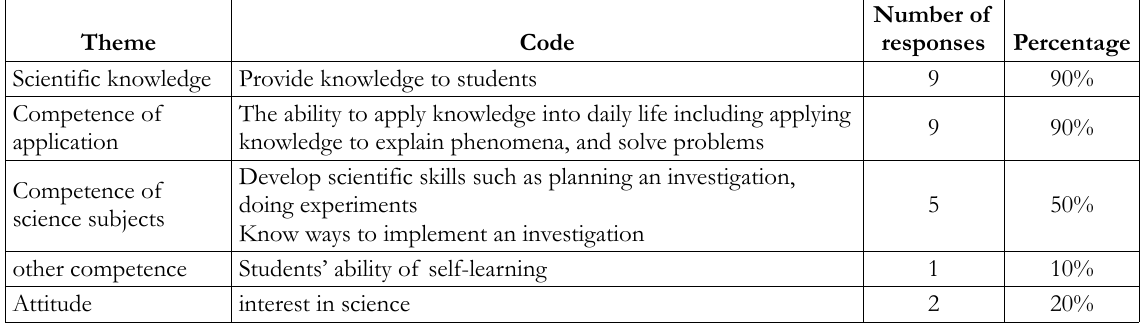
Table 7. Views about the goals of science teaching of school